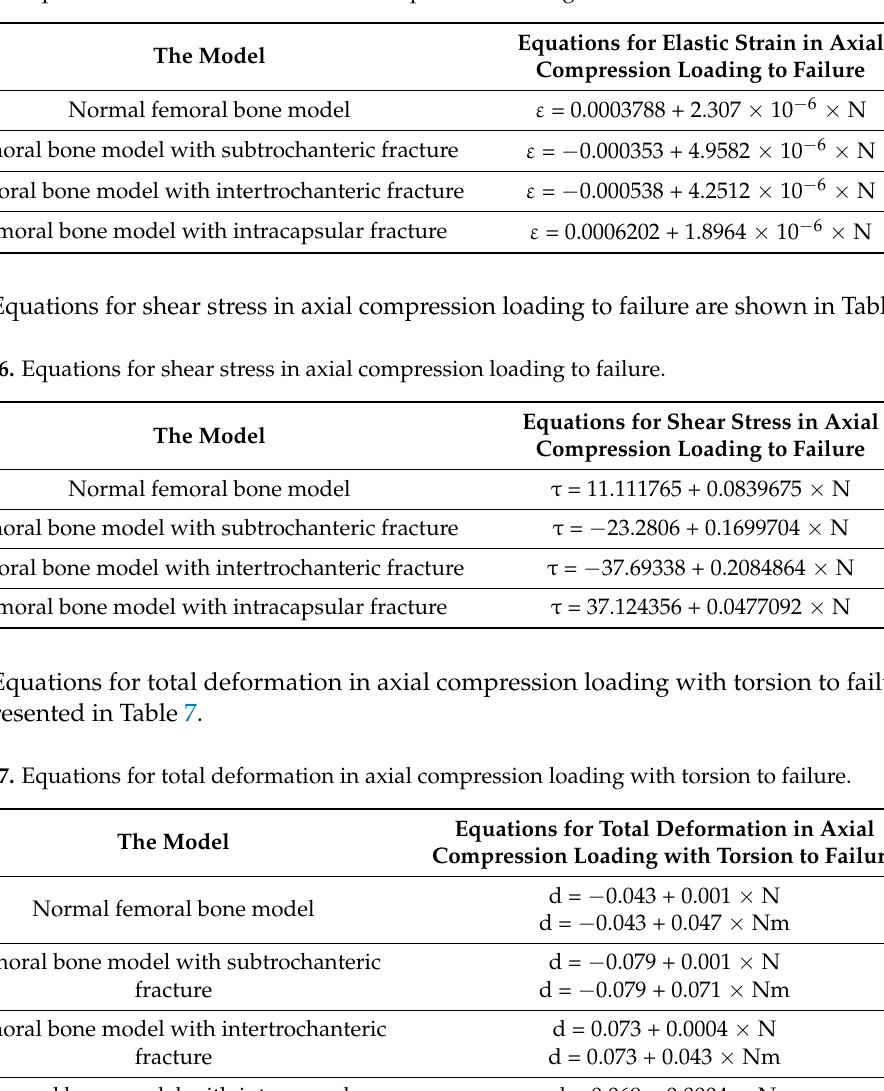
Table 5. Equations for elastic strain in axial compression loading to failure.